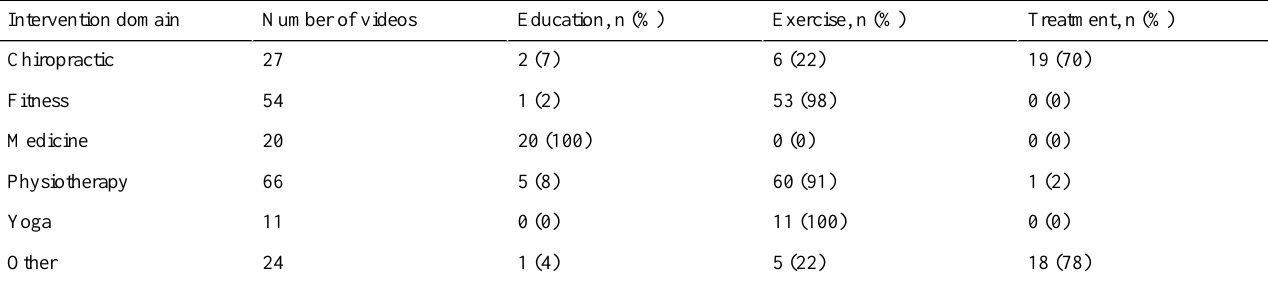
Table 2. Intervention domain by discipline (final data set).